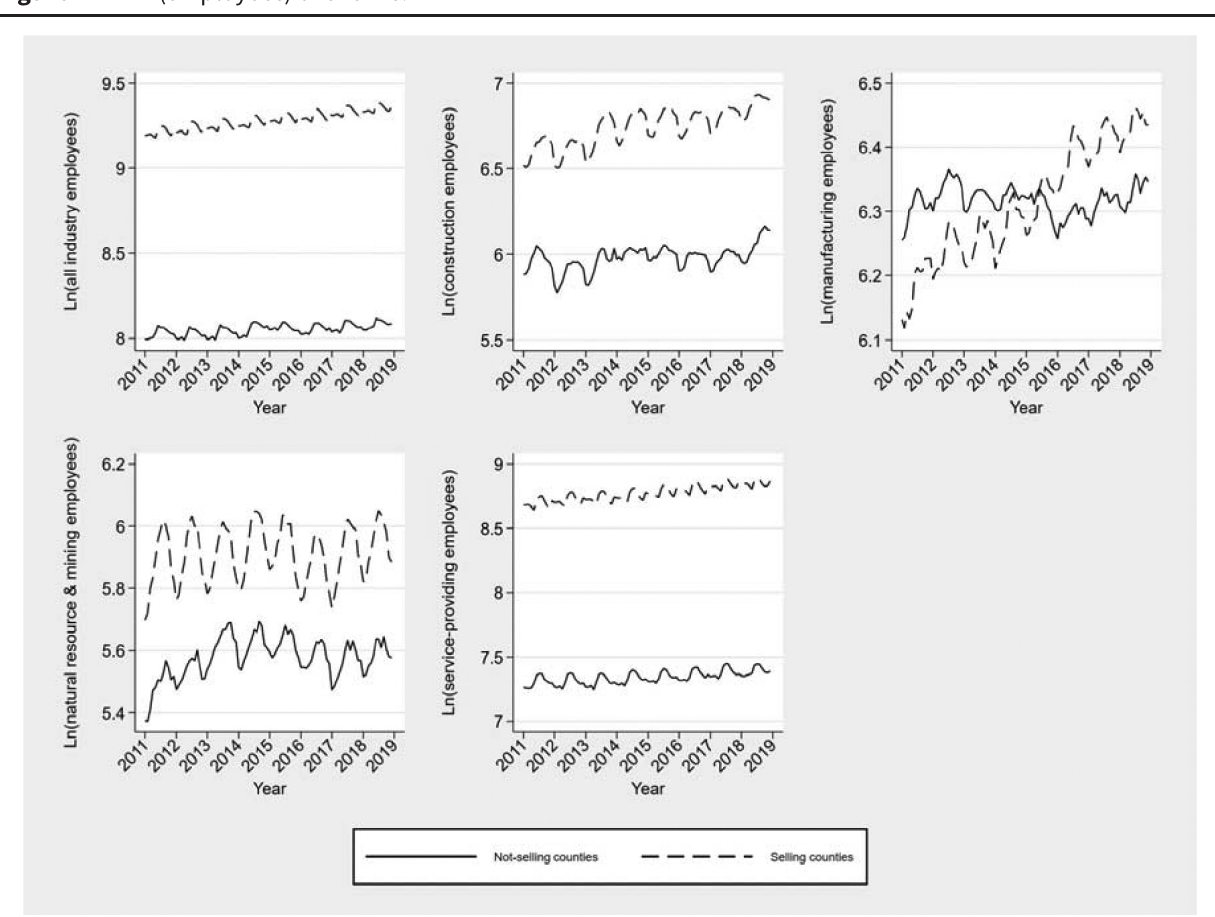
Figure A4 Ln(employees) over